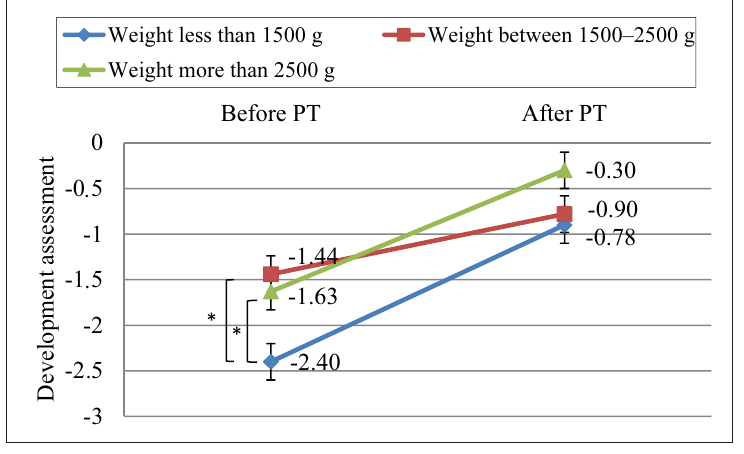
Figure 3. Walking development evaluation in different birth weight infant groups Figure 4. Grasping up development evaluation in different birth weight infant